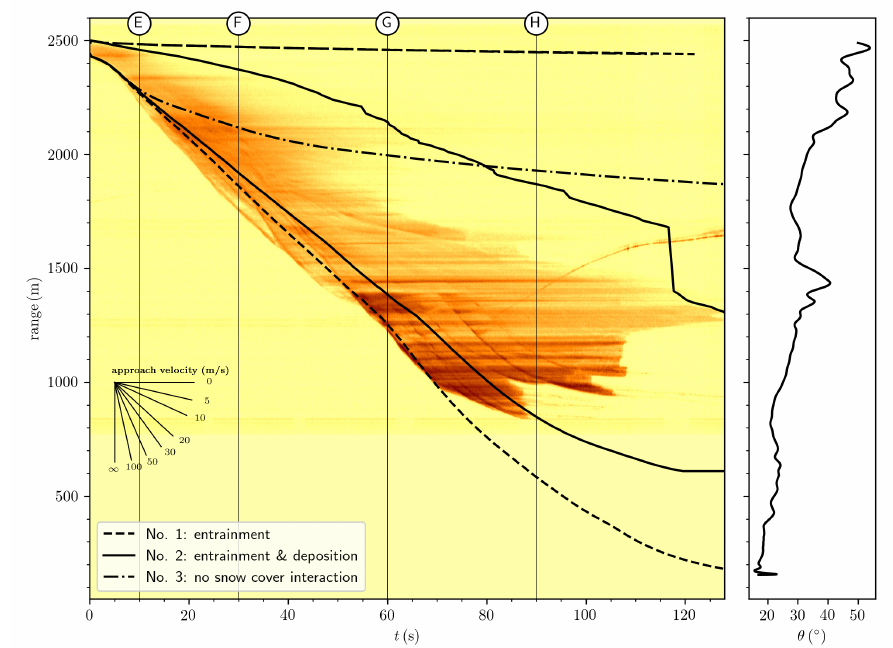
Figure 5. Moving target identification plot of avalanche #0019. The GEODAR data are shown in the background. Black lines give the front and tail position extracted from the simulations. No optimization of parameters has been conducted for this avalanche, but material and model parameters are taken from optimization to avalanche #0017 in Figure 4. Simulation no. 1 solely includes entrainment, simulation no. 2 includes entrainment and deposition, vertical lines correspond to the snapshots ( E – H ) in Figure 6. Simulation no. 3 is drawn as reference without entrainment and deposition. The slope angle along the line of steepest descend is shown in the right panel. A velocity legend is included for quick translation of front inclination to approach velocity. Black lines represent the front and tail position extracted from simulations (Section